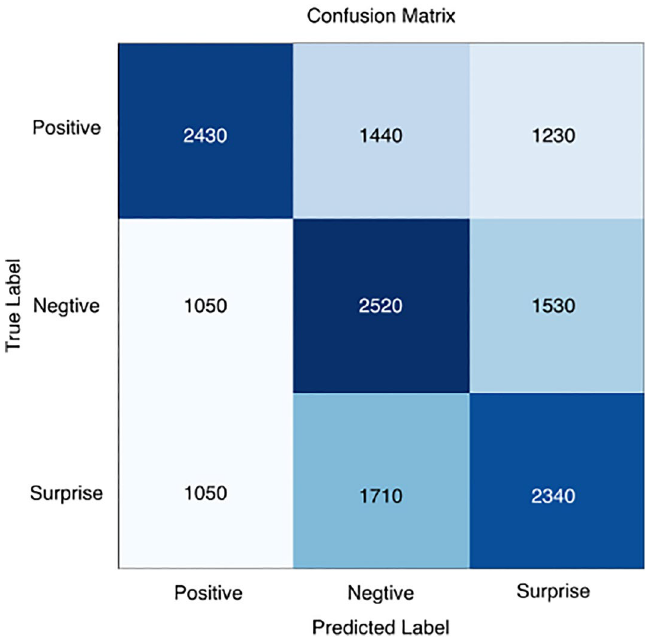
Figure 7. ShuffleNetV2 with CBAM is not pre-trained for optical flow features.